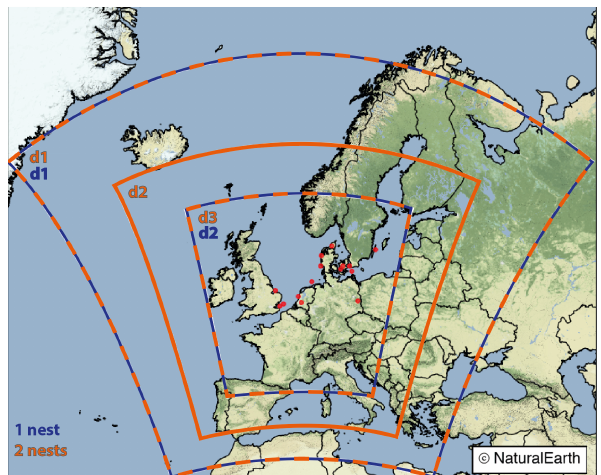
Figure 1. Location of the domains used in the WRF model sim- ulations for two configurations: (1) single nest (domains 1 and 2, in blue) and (2) two nests (domains 1, 2, and 3, in orange). The red dots show the wind speed measurements locations. Base map created with Natural